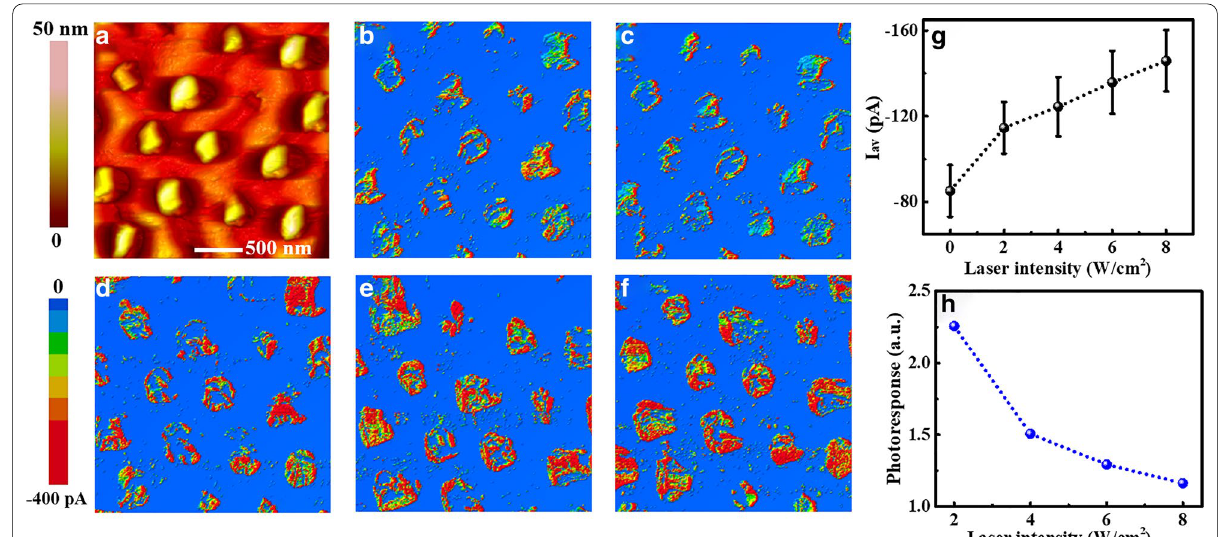
Fig. 2 The topography ( a ) and current images of Si NWs with the length of 800 nm and diameter of 190 nm under different laser intensities of b 0, c 2, d 4, e 6 and f 8 W/cm 2 . g presents the averaged current ( I av ) over the nanowires as a function of laser intensity. h shows the photoresponse as a function of laser